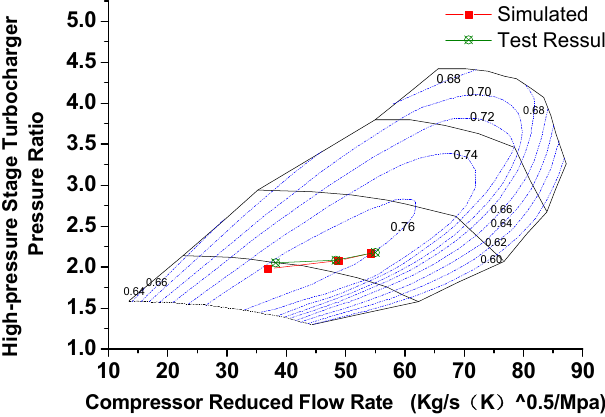
Figure 11. Comparison between high-pressure stage simulation and test results.